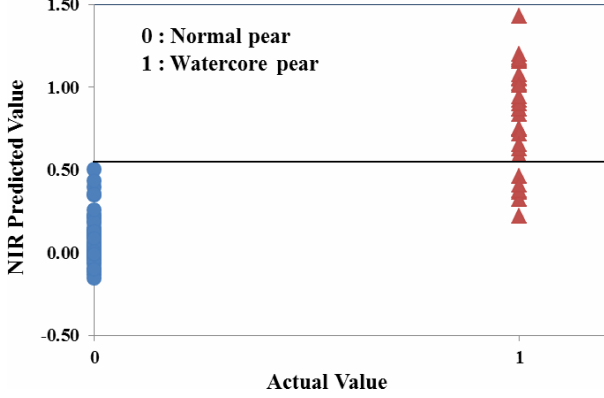
Fig. 9. The PLSDA plot of NIR predicted value and actual value for discriminating watercore-damaged pears (0 ¼ accepted , 1 ¼ rejected ).